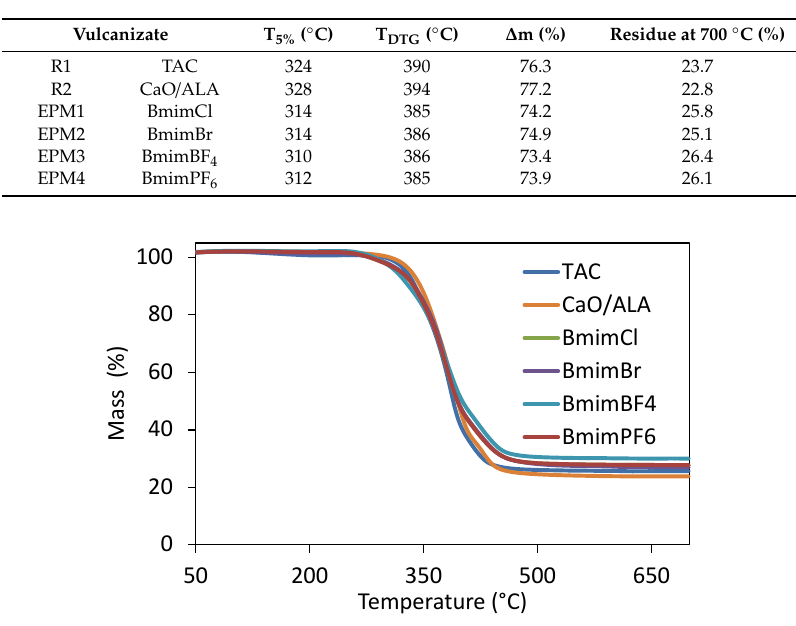
Table 10. Decomposition temperature at 5% of the mass change (T 5% ), DTG peak temperature (T DTG ), and total mass loss ( ∆ m) during decomposition of the EPM vulcanizates (standard deviations: T 5% , T DTG ± 3 ◦ C; ∆ m ± 1.5%).